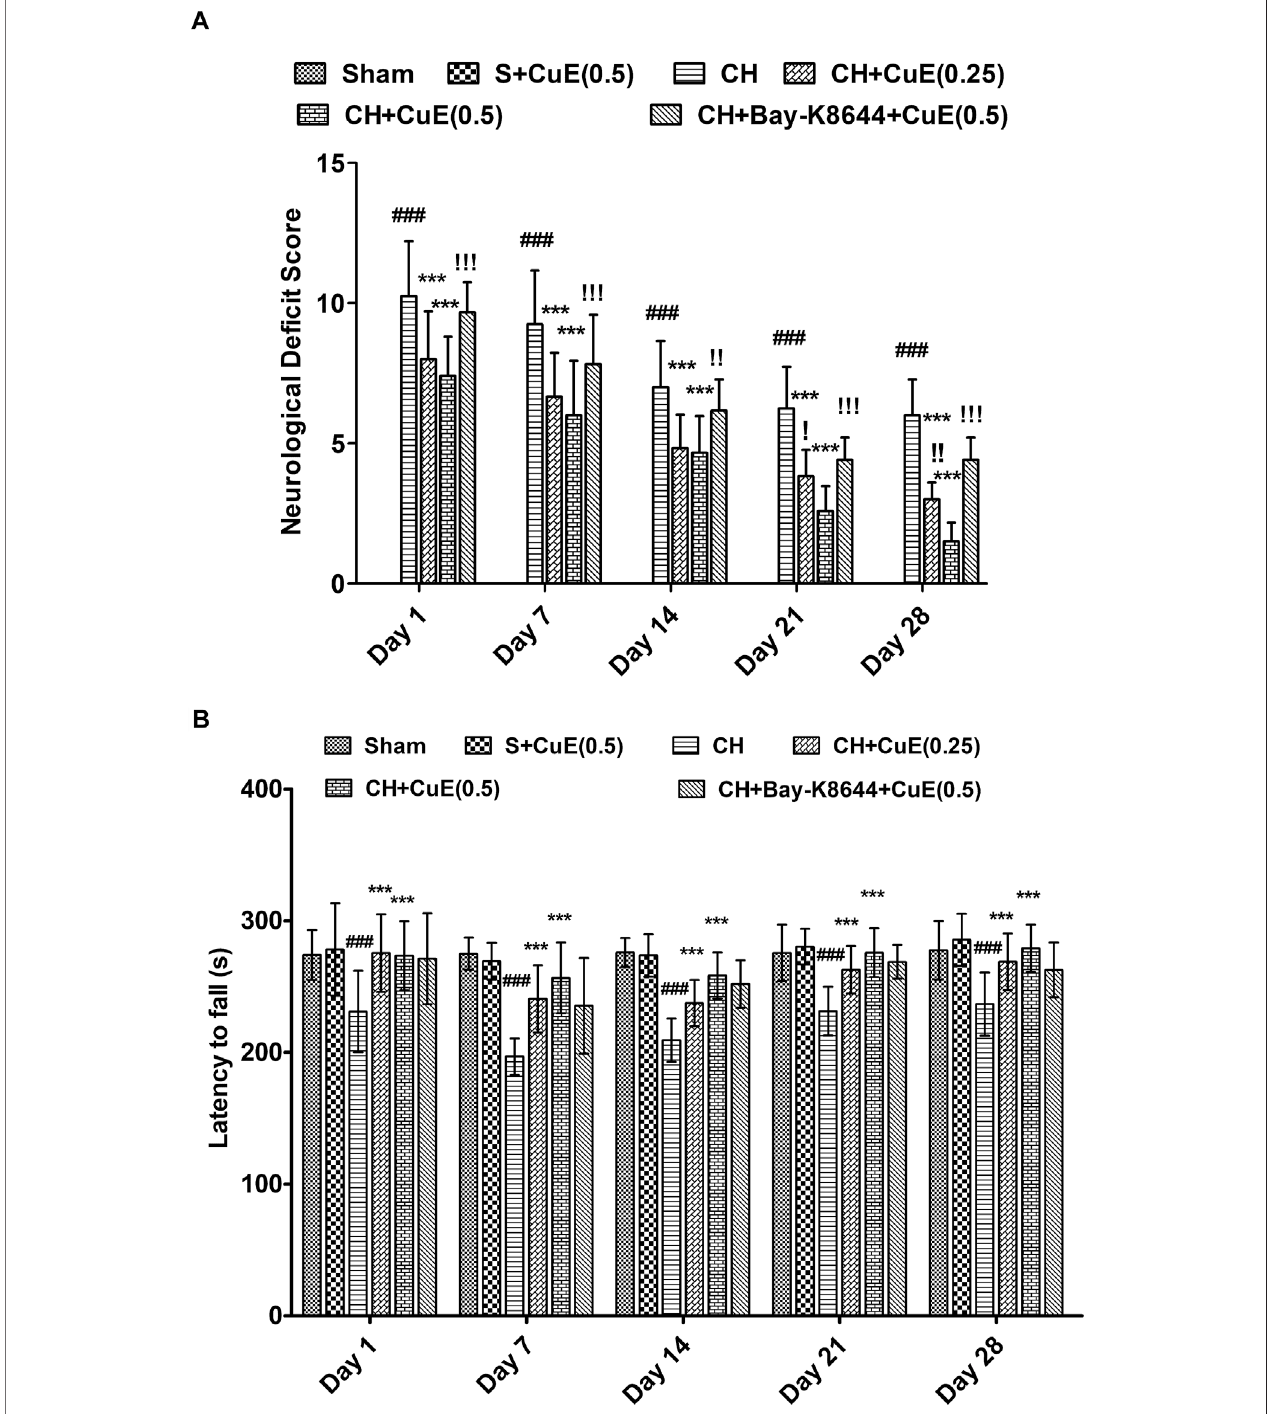
FIGURE 1 | CuE, 0.25 and 0.5 mg/kg, p.o. , post-treatment for 28 days attenuated neurological and sensorimotor de fi cits in rats subjected to CH on day 1. Neurological de fi cit scores (12-point scale) (A) and latency to fall (s) in rotarod test (B) evaluated on different days. Bay-K8644 signi fi cantly attenuated CuE-induced decrease in mNSS. Data expressed as mean ± S.D. ( n (cid:1) 12). ### ( p < .001) vs. Sham (S) group; *** ( p < .001) vs. CH group; ( p < .05), ( p < .01), ( p < .001) vs. CH + CuE(0.5) group